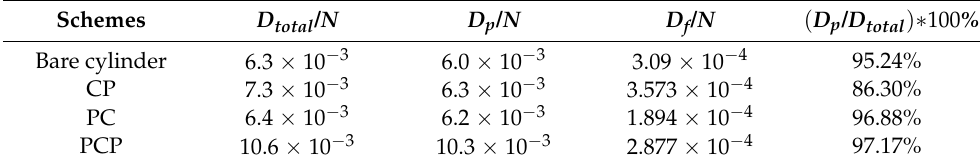
drag. In Figure 7b, the area of region shaped by each curve projected on horizontal axis means the pressure drag of each scheme, which shows that the pressure drag of the PCP scheme is highest among all four schemes. The static pressure drop at the windward side is mainly caused by friction drag, thus Figure 8 illustrates the wall shear stress in x component, which is directly proportional to